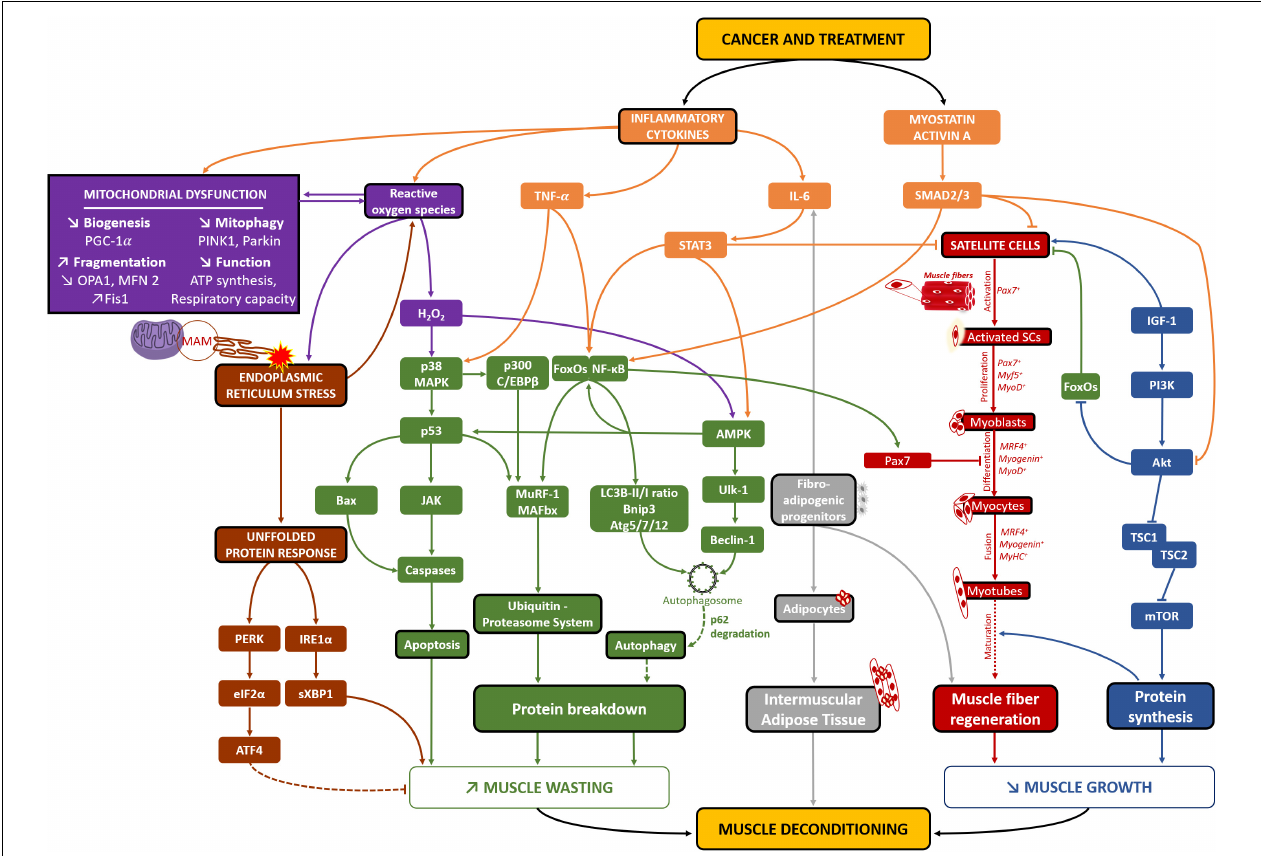
FIGURE 2 | Potential cellular mechanisms of skeletal muscle deconditioning in breast cancer patients. Through the analysis of clinical and pre-clinical studies related to all cancer’s types, several different pathways may be implicated in skeletal muscle deconditioning in breast cancer patients. Both the cancer per se and its treatment lead to increased levels of inflammatory cytokines and Myostatin/Activin A pathways (in orange), consequently decreasing protein synthesis (in blue) and increasing pathways implicated in protein breakdown (in green). The activation of the autophagy-lysosomal system needs to be elucidated as an increase in autophagosomes formation has been consistently found as well as increased levels of p62, suggesting that lysosome activity might be disrupted in cancer cachexia, leading to no change in autophagy flux (green dotted line). The combination of high levels of inflammatory cytokines, ROS and mitochondrial altered dynamics, biogenesis and function (in purple) would also lead to increased protein breakdown and apoptosis. On the other hand, it would also lead to high levels of endoplasmic reticulum stress, resulting in an increase in the UPR system (in brown) and consequently protein breakdown. The involvement of the PERK/eiF2 α /ATF4 pathway, known to be implicated in non-cancer models of muscle atrophy, needs to be clarified, as it might surprisingly be necessary to counteract muscle atrophy in cancer-related models of muscle atrophy (brown dotted line). Moreover, different studies also highlighted a reduction in the number of satellite cells (SCs), their capacity to differentiate and skeletal muscle capacity to regenerate, emphasizing that cancer-related muscle atrophy may also result from muscle altered repair/regrowth (in red). Finally, increased presence of fibro-adipogenic progenitors might also be implicated in muscle deconditioning as they are implicated in both IL-6-mediated muscle atrophy (in non-cancer models of muscle atrophy) and Intermuscular adipose tissue development (in gray). Altogether, these cellular mechanisms might play an important role in breast cancer-related skeletal muscle deconditioning and clearly need to be further investigated through clinical studies using muscle biopsies. MAM, mitochondria-associated ER